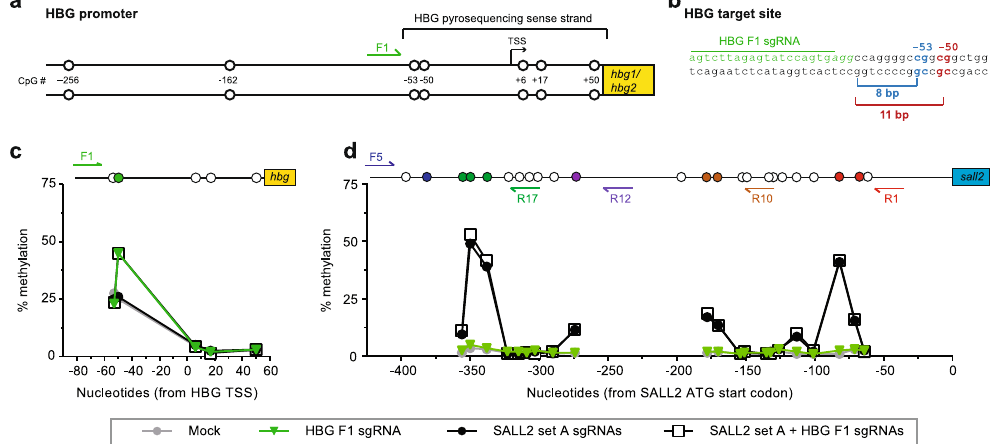
Figure 7. Methylation at multiple promoters using multiplexed sgRNAs. ( a ) Schematic of the HBG (fetal hemoglobin) human promoters with CpG sites (circles) marked by position from the transcription start site (TSS). The relative position of the HBG F1 sgRNA site (green) is shown on the promoter along with ( b ) the detailed nucleotide sequence showing the PAM site in italics. The − 50 (red) CpG site is at a good gap distance for methylation whereas the − 53 (blue) CpG is not. Representative pyrosequencing data showing the percent methylation in the ( c ) HBG or ( d ) SALL2 promoter in HEK293T cells cotransfected with pCMV-sMTase and the indicated single or multiplexed sgRNAs. The promoter schematics above the graphs indicate the location of sgRNA binding sites and CpG sites (circles). Filled circles indicate the CpG sites at which some level of methylation was expected based on our design